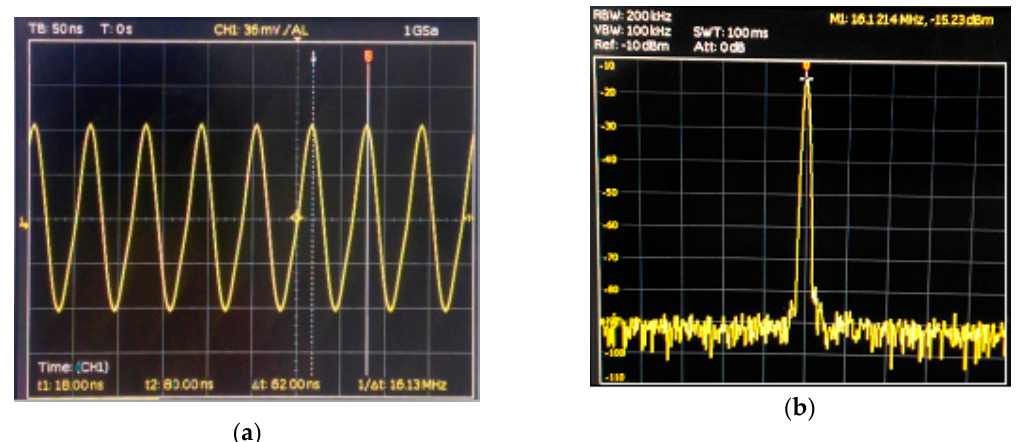
Figure 10. ( a ) The oscillogram of the oscillator output voltage; ( b ) The measured spectrum of the oscillator output power with span of 20 MHz.